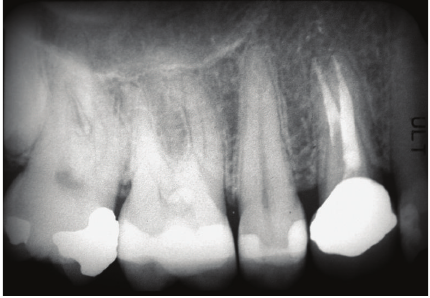
Figure 3: Periapical radiograph showed a fracture of the root, with a mesial well-defined lesion of the hard tissue of the upper right first premolar, as the radiolucent area affected the root surface of the tooth.